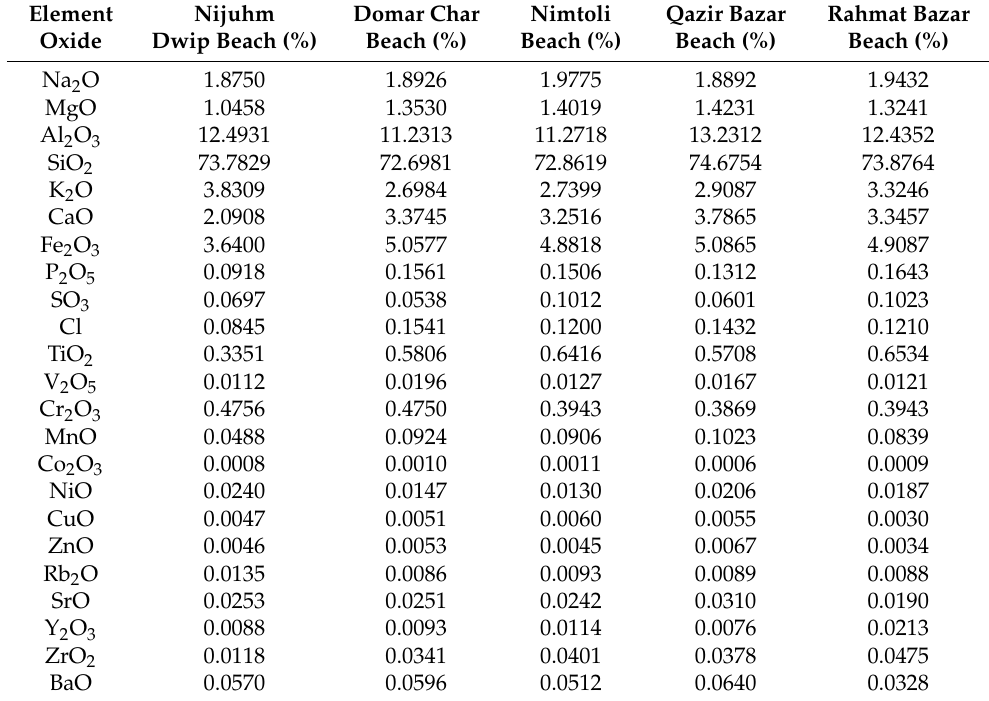
Table 4. Geochemistry of the raw sand carried out through